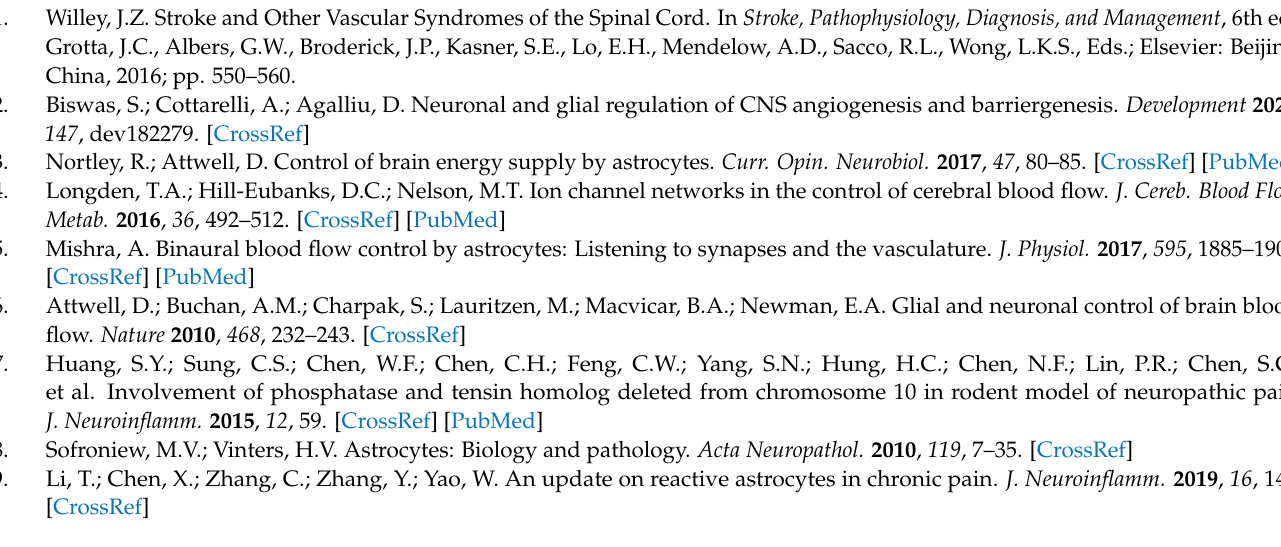
cropped images of Western Blots in Figure 1C: VEGF and β -actin. Figure S3: Effects of fumagillin intrathecal administration on the pain behaviors evoked by chronic constriction injury (CCI) in rats. Figure S4: Effects of intrathecal administration of anti-vascular endothelial growth factor − A (anti − VEGF − A) monoclonal antibodies (0.3 µ g/day) for 14 consecutive days on chronic constriction injury (CCI)-induced nociceptive